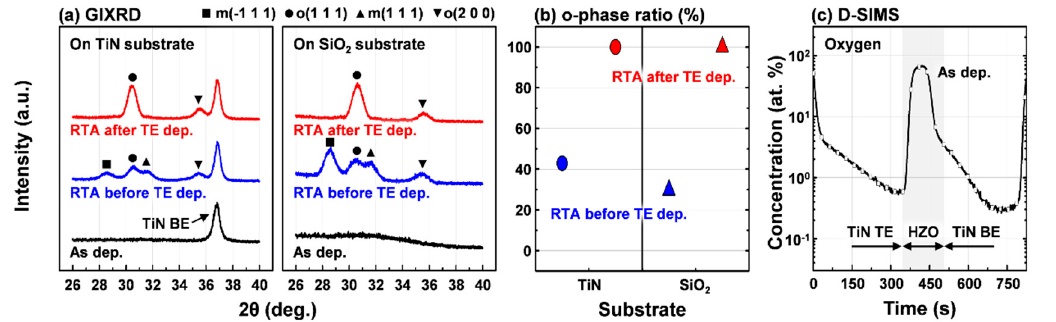
Figure 5. ( a ) The GIXRD patterns of 10-nm-thick HZO films on different substrates: as-deposited HZO films and HZO films annealed at 400 °C before and after TiN top electrode deposition; ( b ) the relative ratio of the area of o(1 1 1)/{m(-1 1 1)+o(1 1 1)+m(1 1 1)} of the HZO films calculated from the deconvoluted GIXRD patterns; ( c ) the D-SIMS depth profile of the as-deposited HZO film sandwiched between the TiN top and bottom electrodes.